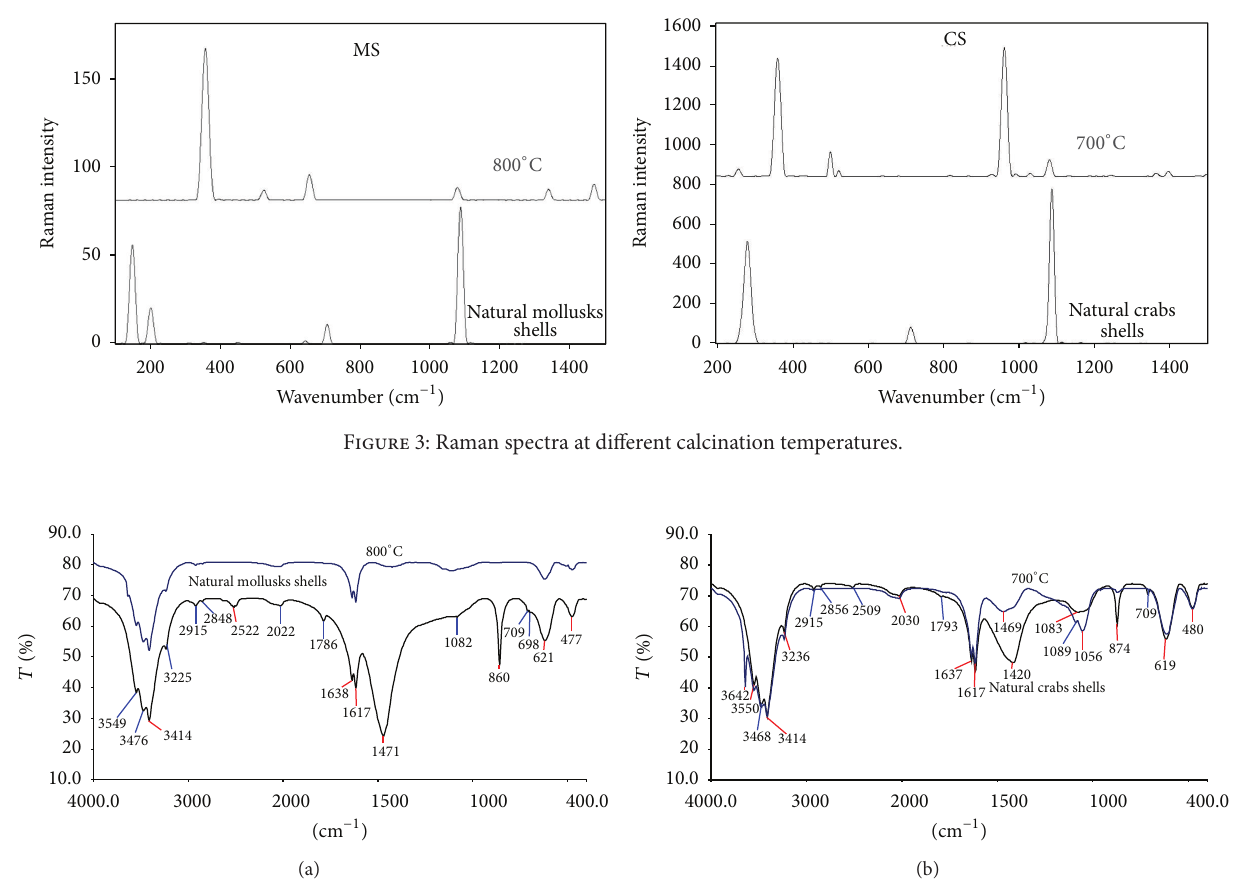
Figure 4: FTIR spectra of mollusks shells (a) and crabs shells (b) at different calcination